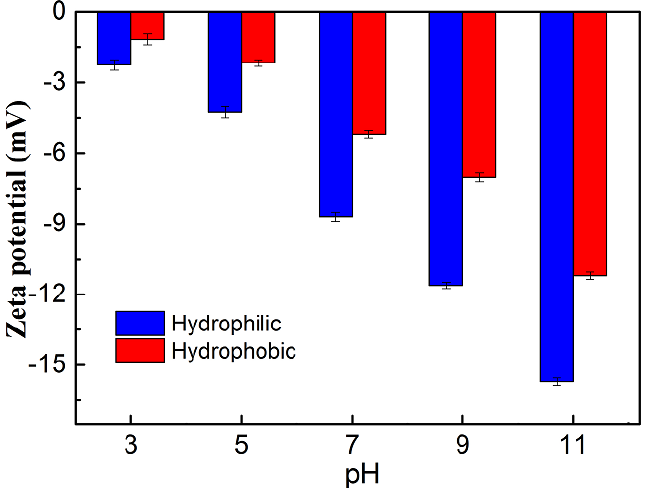
Figure 12. Adsorption capacities of RhB for the hydrophilic and hydrophobic ZrO 2 -SiO 2 xerogels at different pH (dosage = 0.05 g, contact time = 120 min, RhB concentration = 140 mg · L − 1 , T = 25 ◦ C).